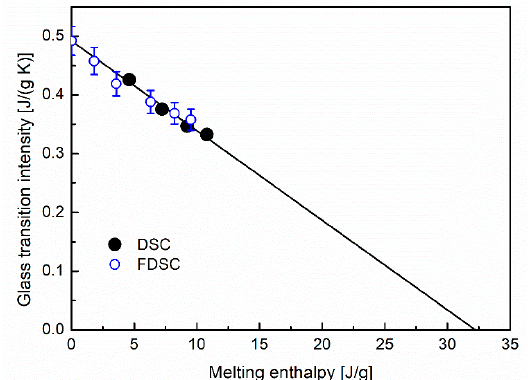
Figure 3. Glass transition intensity, Δ c p , versus specific melting enthalpy, Δ h m , for HNBR crystallized at − 10 °C. The data are measured by DSC (solid dots) and FDSC (open dots).